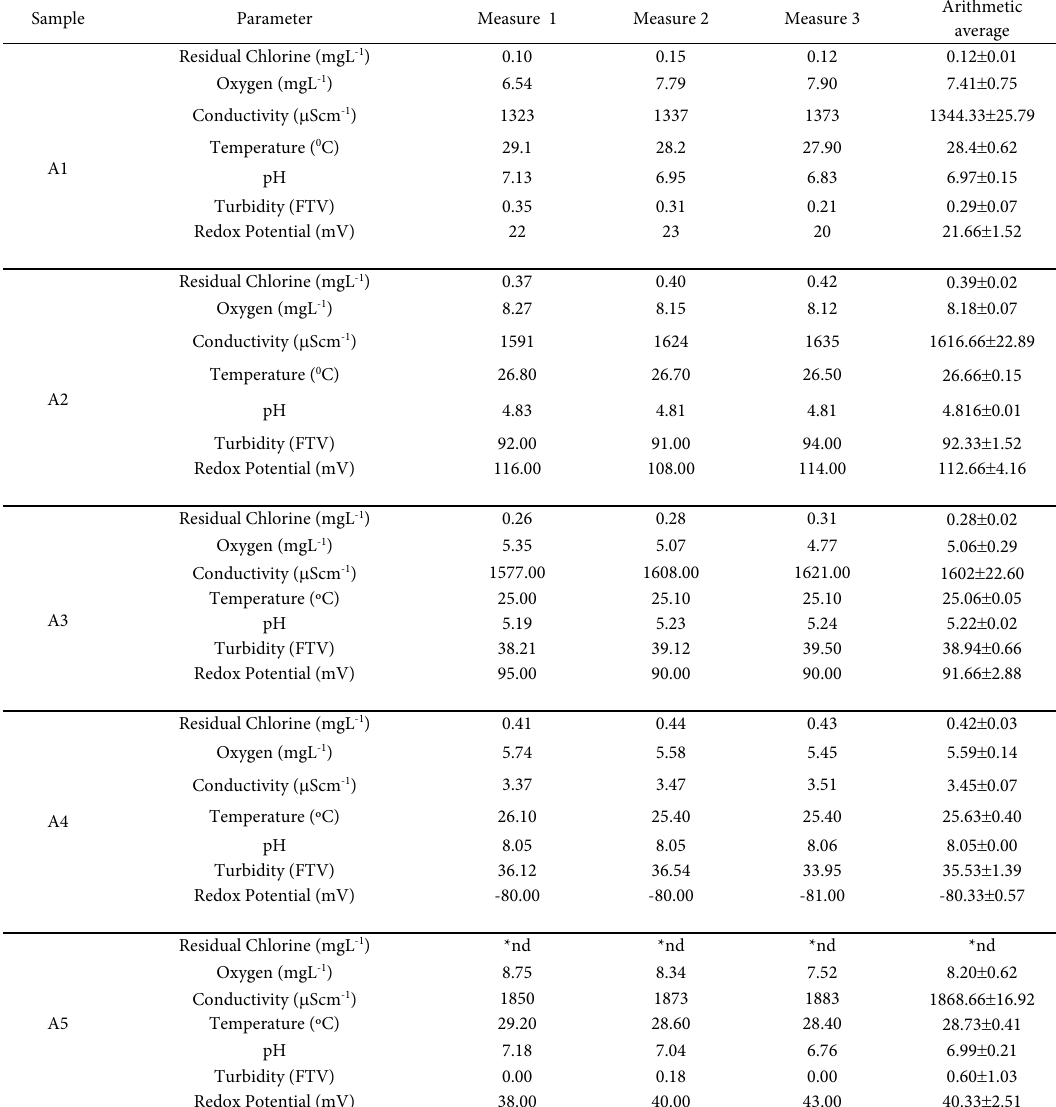
Table 3 Physicochemical parameters